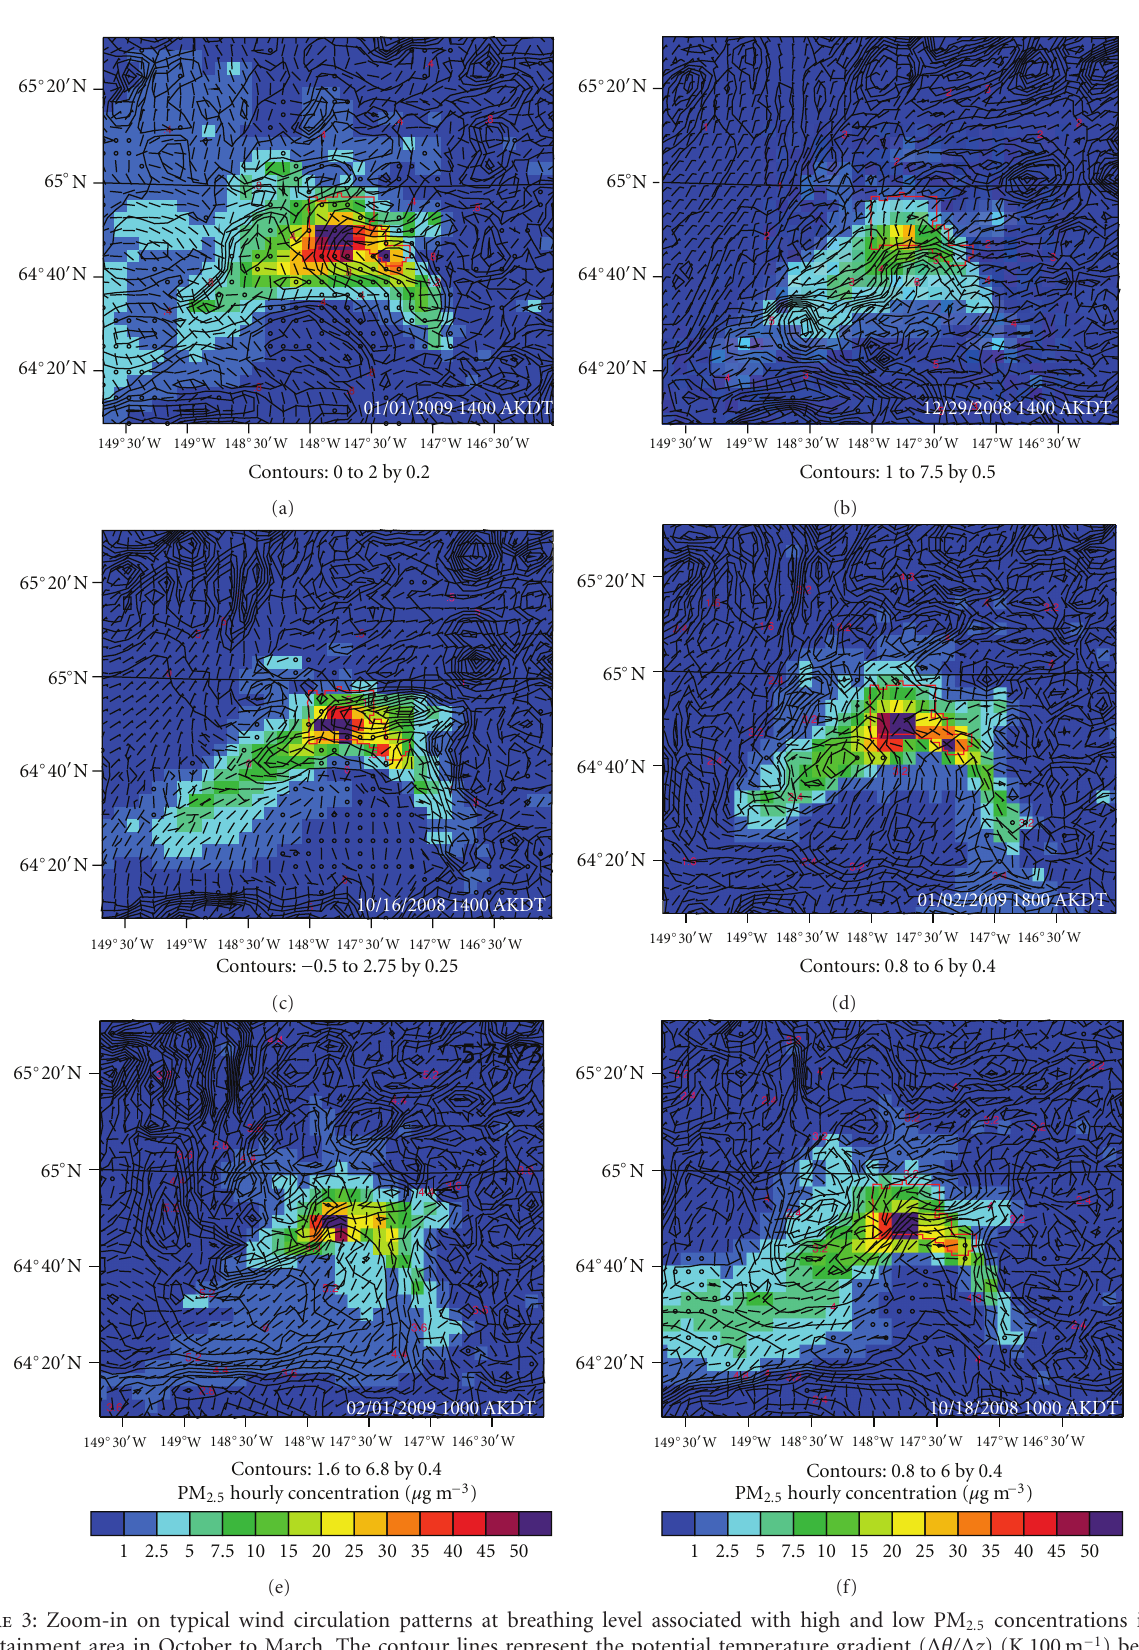
Figure 3: Zoom-in on typical wind circulation patterns at breathing level associated with high and low PM 2 . 5 concentrations in the nonattainment area in October to March. The contour lines represent the potential temperature gradient ( Δ θ/ Δ z ) (K.100m − 1 ) between the surface and 150m above the ground; the red polygon indicates the nonattainment area. The community of North Pole is located in the lower right region of the nonattainment